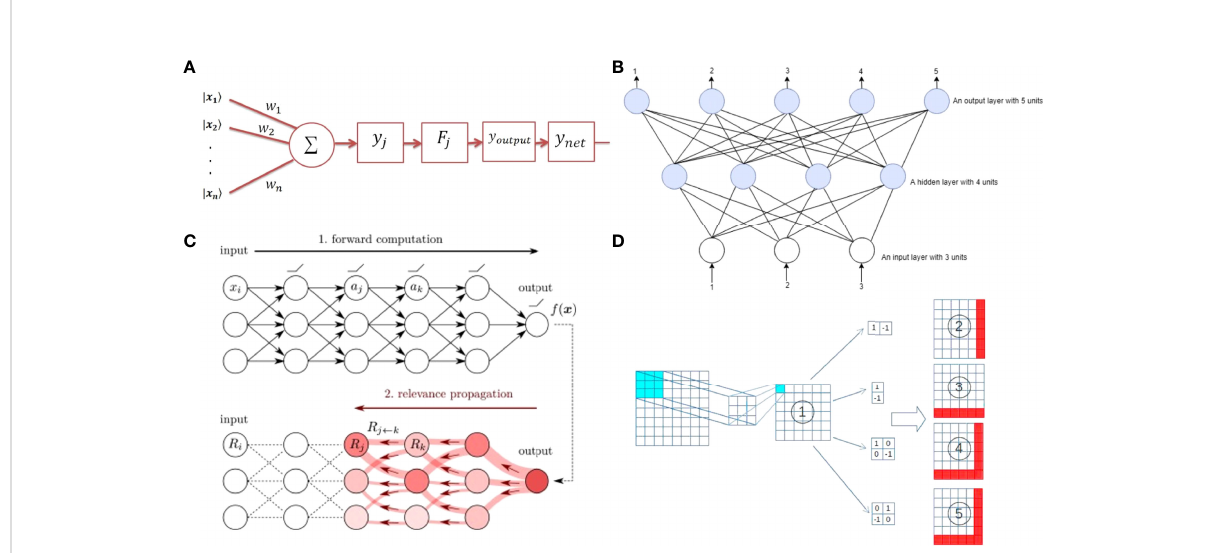
FIGURE 4 (A) Structure of a perceptron. (reproduced from an open access article). (B) Schematic diagram of an arti fi cial neural network. (reproduced from an open access article). (C) Data forward propagation and error back propagation of a deep neural network. (reproduced from an open access article). (D) Diagram of convolution operation. (reproduced with permission from Sar ı gül et al.,